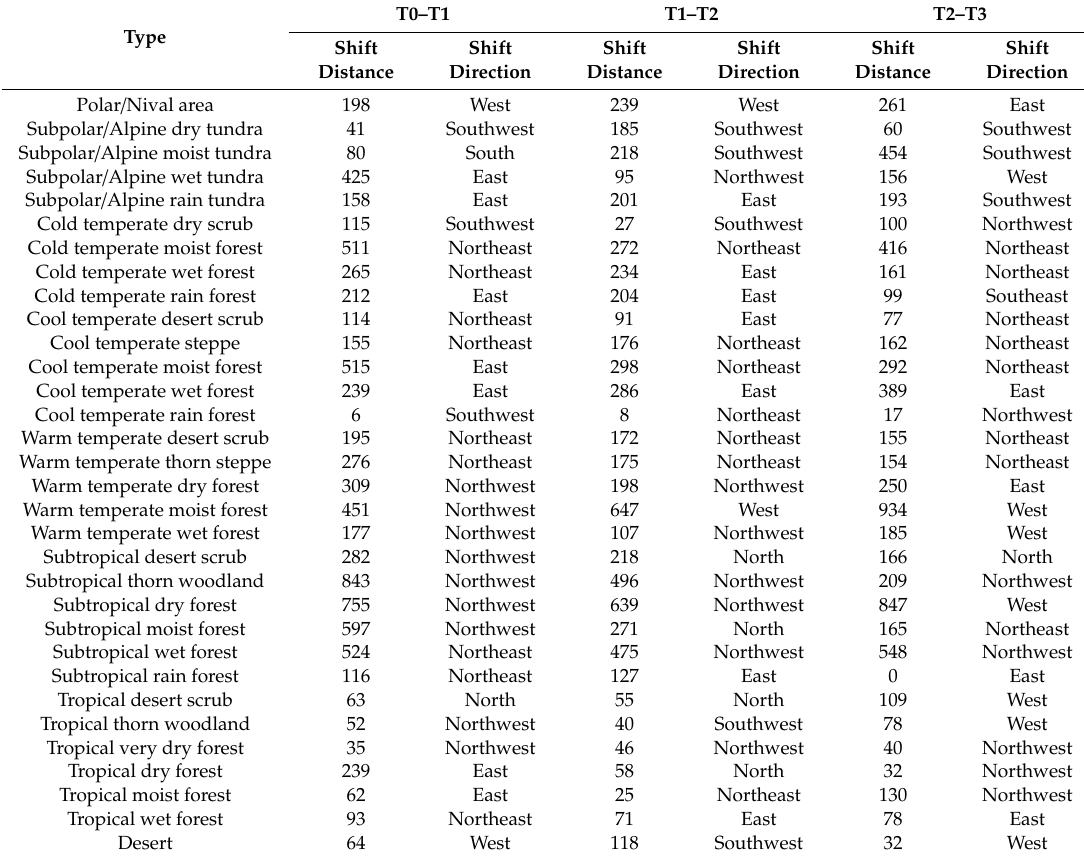
Table 2. Shift distances (km) and directions of the mean center of each potential vegetation type under the RCP2.6 scenario in